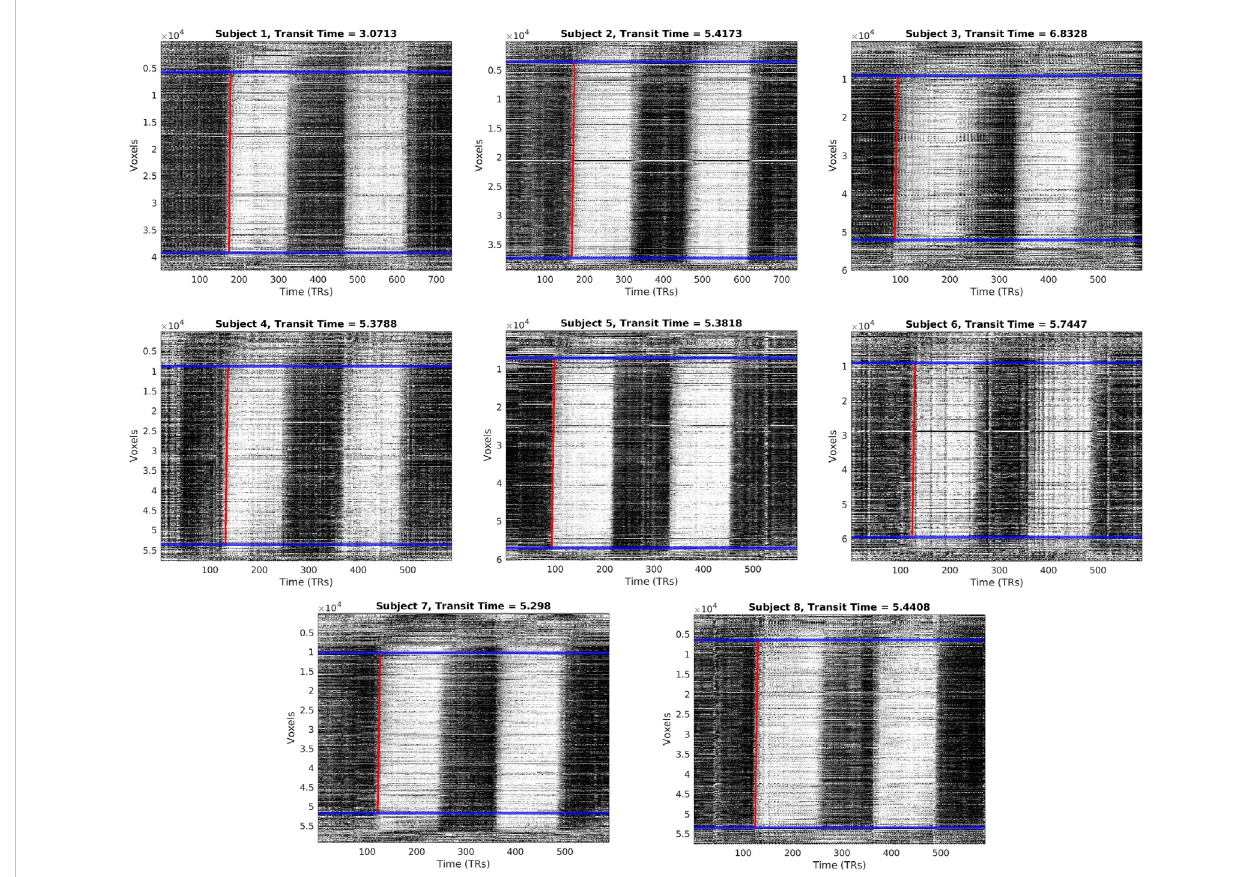
FIGURE 2 Carpet plots and transit times for each CO 2 subject. Blue lines indicate boundaries for image cropping before edge detection. Red lines indicate the computed edge associated with the arrival of the CO 2